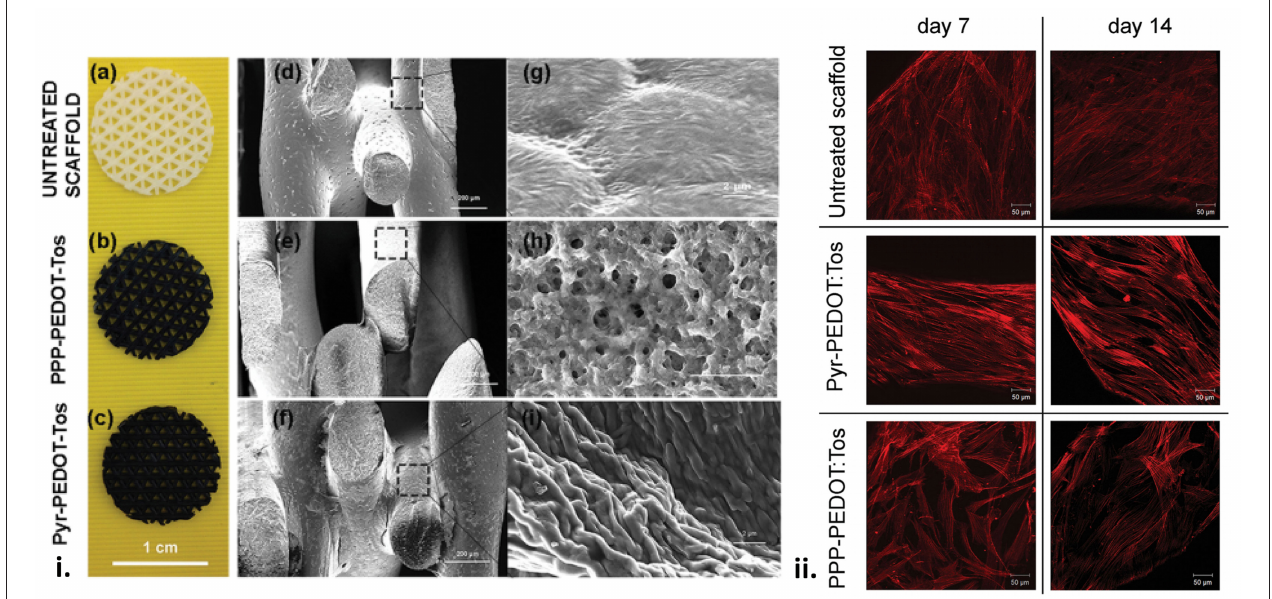
FIGURE 6 | (i) Scaffolds surface structure. (a,d,g) Pictures of the uncoated and coated scaffolds and SEM images of the macroporous scaffolds before and after VPP using the two different oxidant solutions. (b,e,h) PPP-PEDOT:Tos scaffolds and (c,f,i) Pyr-PEDOT:Tos. (a–c) scale bar: 1cm, (d–f) scale bar: 200 µ m, (g–i) scale bar: 2 µ m). (ii) F-actin staining of foetal mesenchymal stem cells seeded on untreated and coated scaffolds. Z-stack images were taken for cells after 7 and 14 d of proliferation on different scaffolds surfaces. Scale bar: 50 µ m. Reproduced with permission from Iandolo et al.